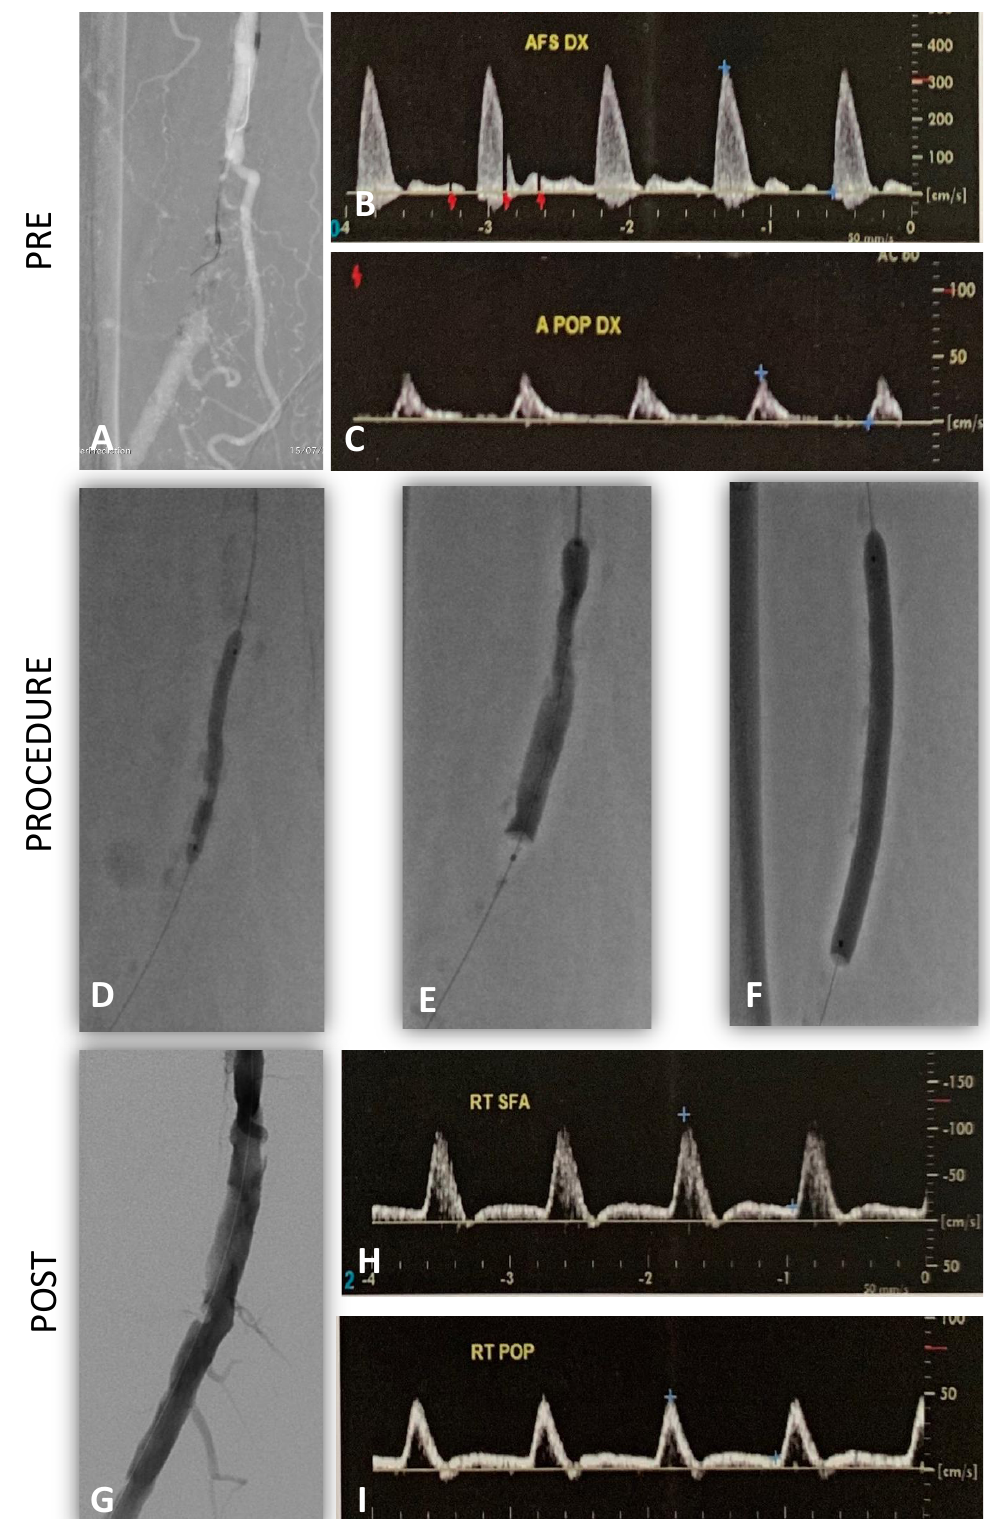
Figure 5. Case 3, right superficial femoral artery subocclusion treated by IVL/DCB. ( A ) Preoperative CA; ( B ) Preoperative DUS superficial femoral artery; ( C ) Preoperative DUS popliteal artery; ( D ) POBA predilatation; ( E ) IVL at first cycle; ( F ) DCB after IVL (10 cycles) treatments; ( G ) Postoperative CA; ( H ) Postprocedural DUS superficial femoral artery; ( I ) Postoprocedural DUS popliteal artery waveforms, changing from monophasic to triphasic